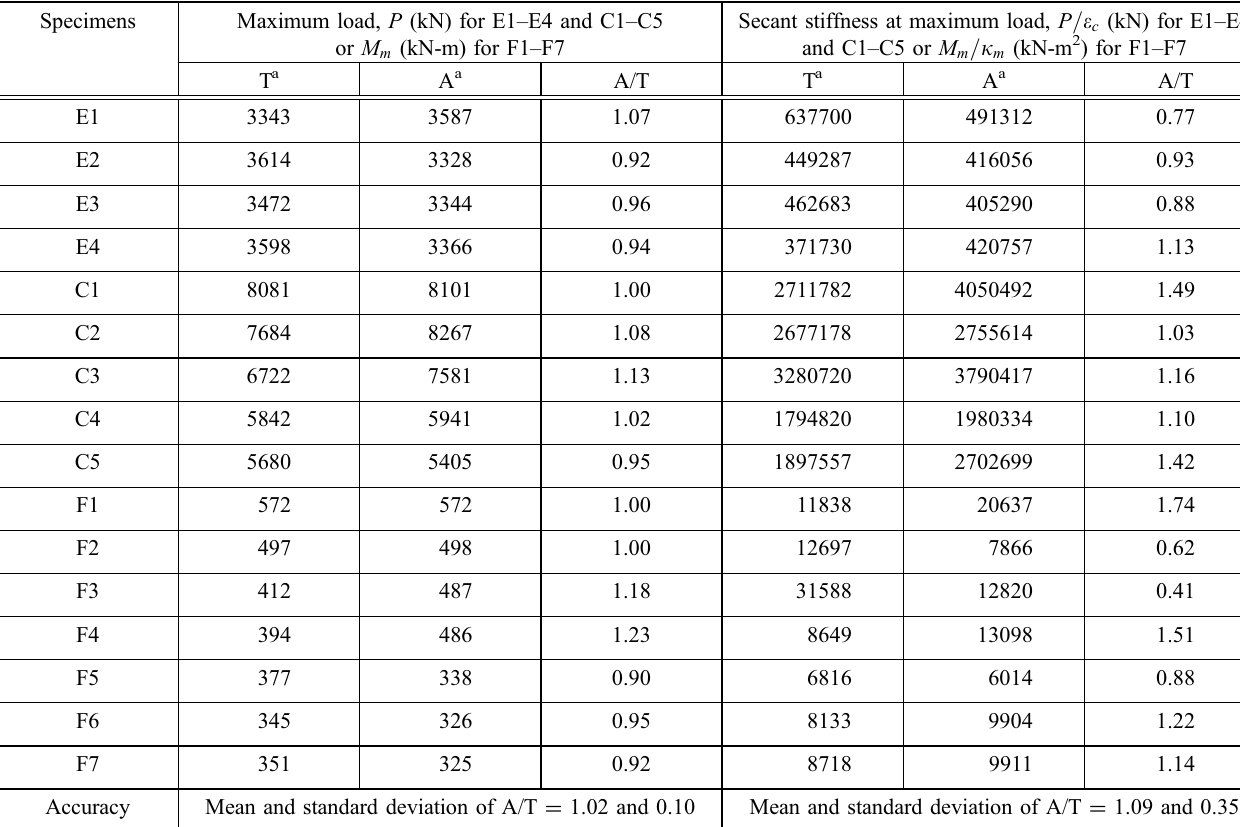
Accuracy Mean and standard deviation of A/T = 1.02 and 0.10 Mean and standard deviation of A/T = 1.09 and 0.35 a T and A indicate the test and analysis results evaluated at the mid-height